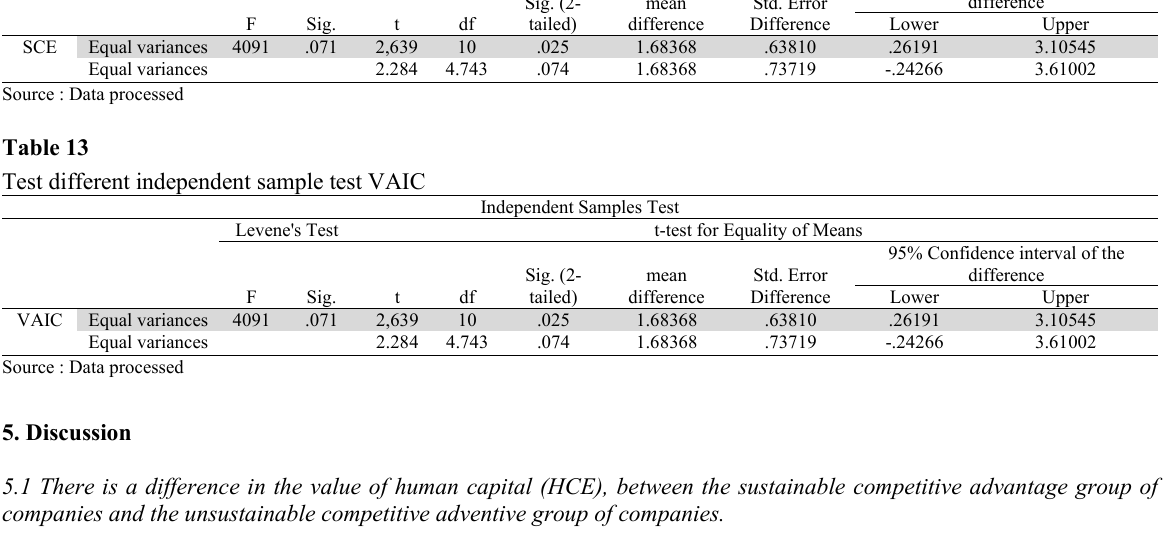
Test different independent sample test SCE Independent Samples Test Levene's Test t-test for Equality of Means